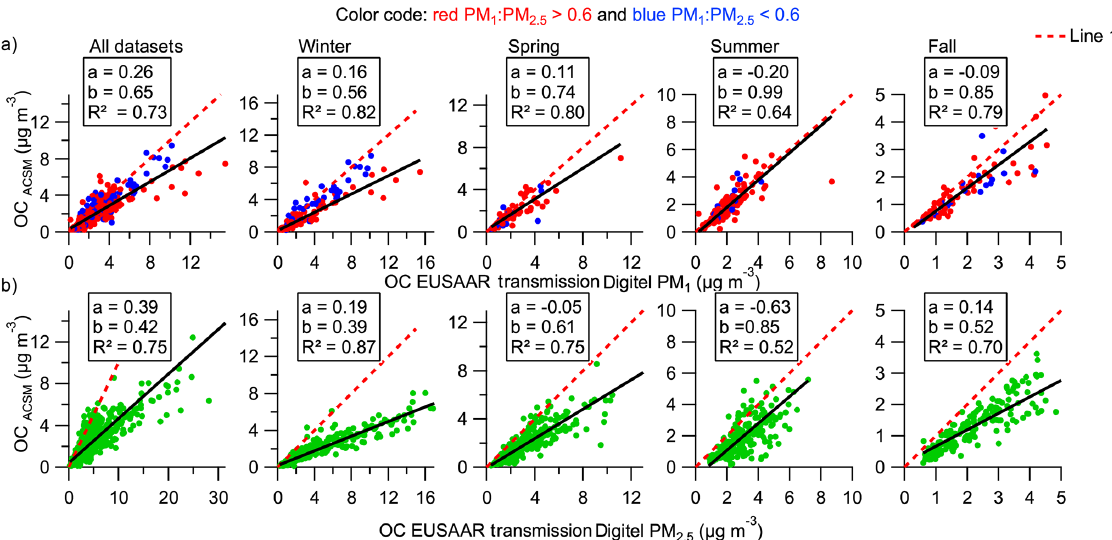
Figure 7. Correlations between the estimated OC ACSM and the offline OC mass concentration over the entire period and seasonality for (a) PM 1 and (b) PM 2 . 5 . Black lines show the least-orthogonal-distance linear fit and the red dotted lines the 1:1 line.